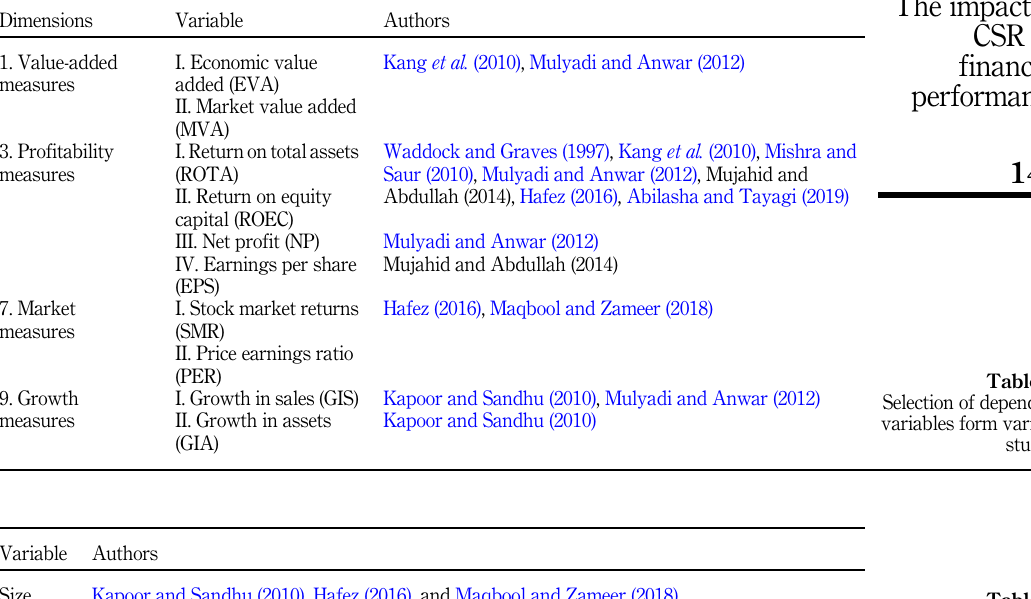
Table 3. Selection of